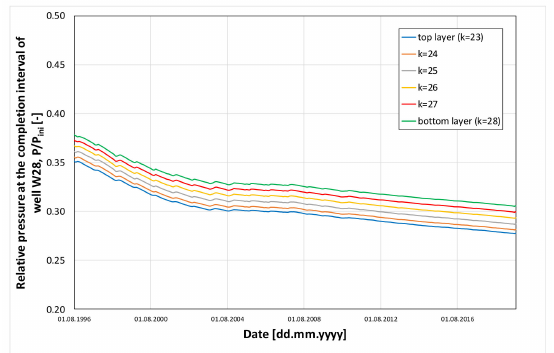
Figure 26. Relative pressure at the completion interval of well W28.